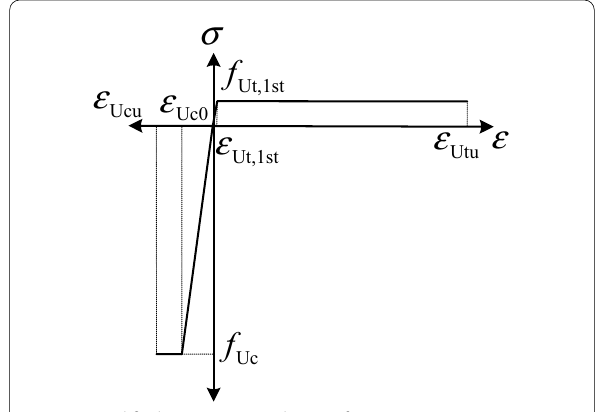
Fig. 2 Simplified stress–strain relation of UHPC.